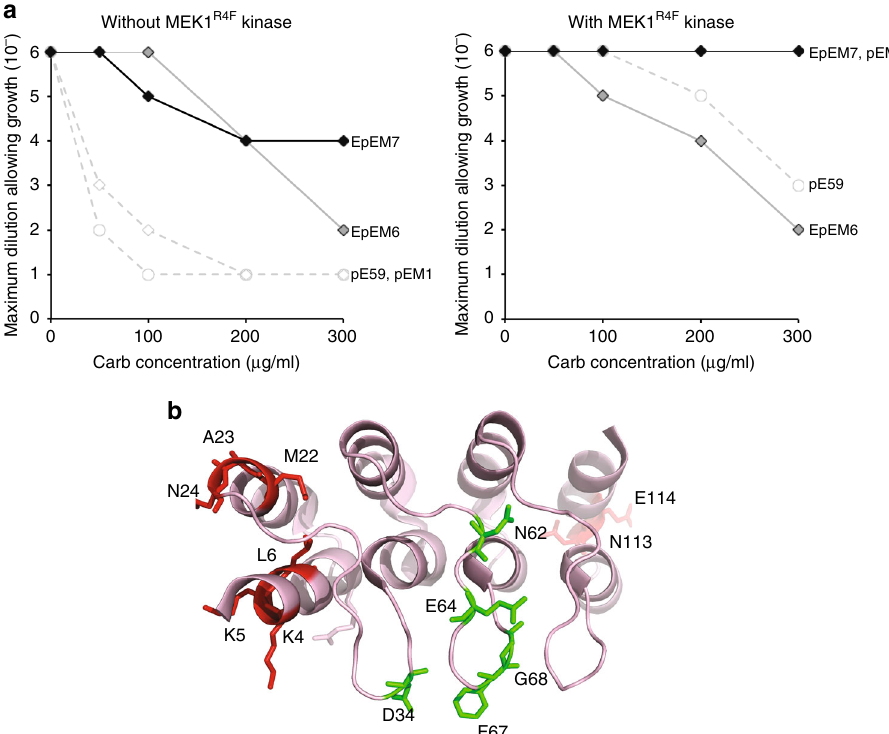
Fig. 5 Isolation of DARPin variants with altered ERK2 speci fi city. a Survival curves for serially diluted E. coli MC4100 cells co-expressing TatABC along with ERK2-Bla and Tat-targeted DARPins EpEM6 (dark gray diamonds) and EpEM7 (black diamonds). Resistance of cells was evaluated in the presence (left) or absence (right) of MEK1 R4F kinase as indicated. Overnight cultures were serially diluted in liquid LB and plated on LB agar supplemented with Carb. Maximal cell dilution that allowed growth is plotted versus Carb concentration. Resistance pro fi les for pERK2-speci fi c DARPins pE59 (empty circles) and pEM1 (empty diamonds) are shown with (left) and without (right) MEK1 R4F for comparison. b Location of mutations in DARPin variants EpEM6 and EpEM7 mapped onto the pE59-pERK2 co-crystal structure. The structure was derived from PDB ID 3ZUV described in Kummer et al. 30 , and the schematic was generated using PyMOL software. The DARPin is shown in light red, and the mutations found in helix and loop secondary structures in red and green, respectively. Source data for this fi gure is available in the Source Data